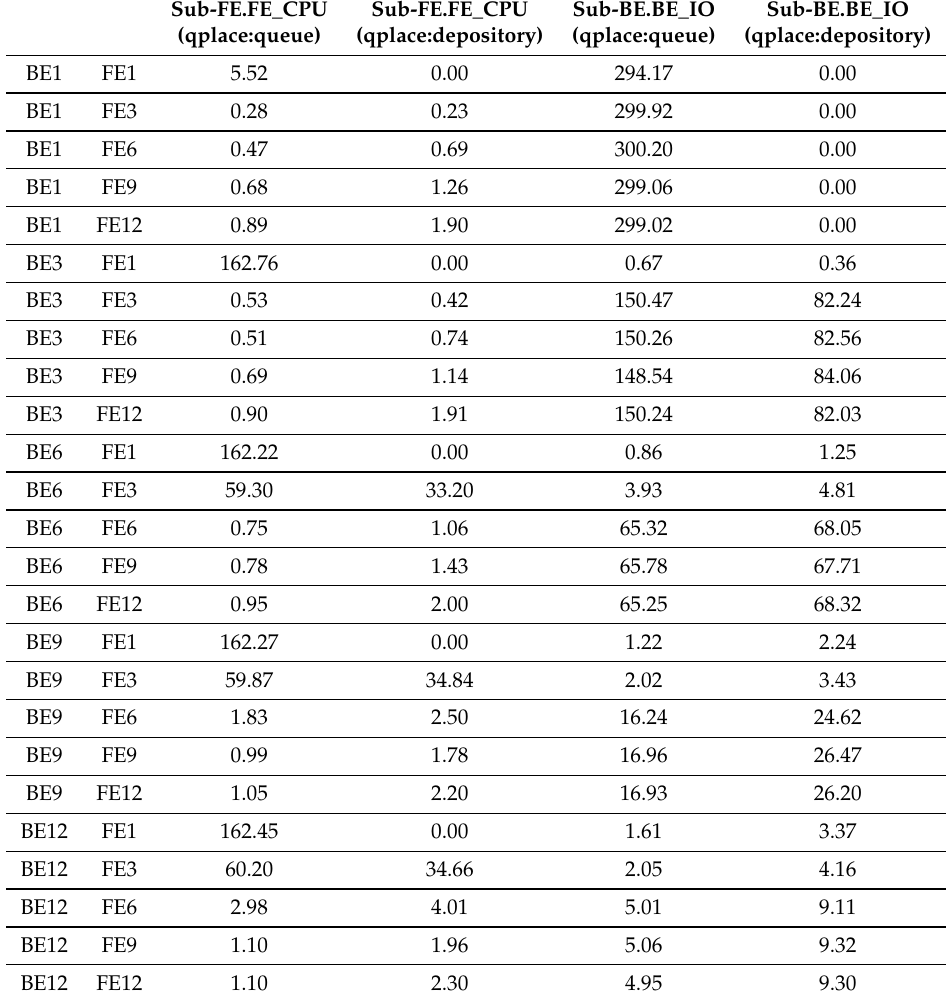
Table 3. Case with parameters: 3000 threads per FE node, 4000 database connections per BE